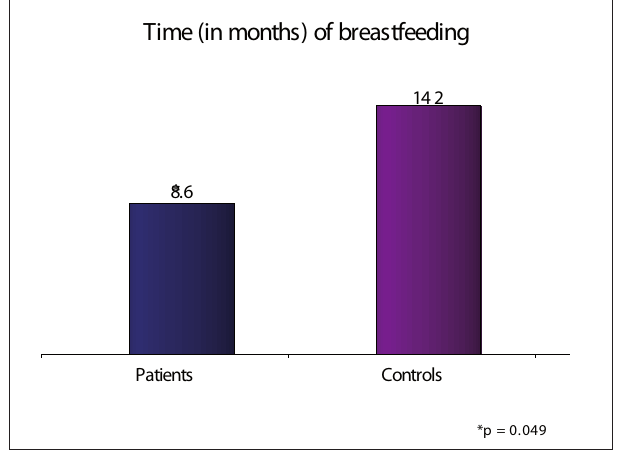
Fig. 2. Duration of breastfeeding